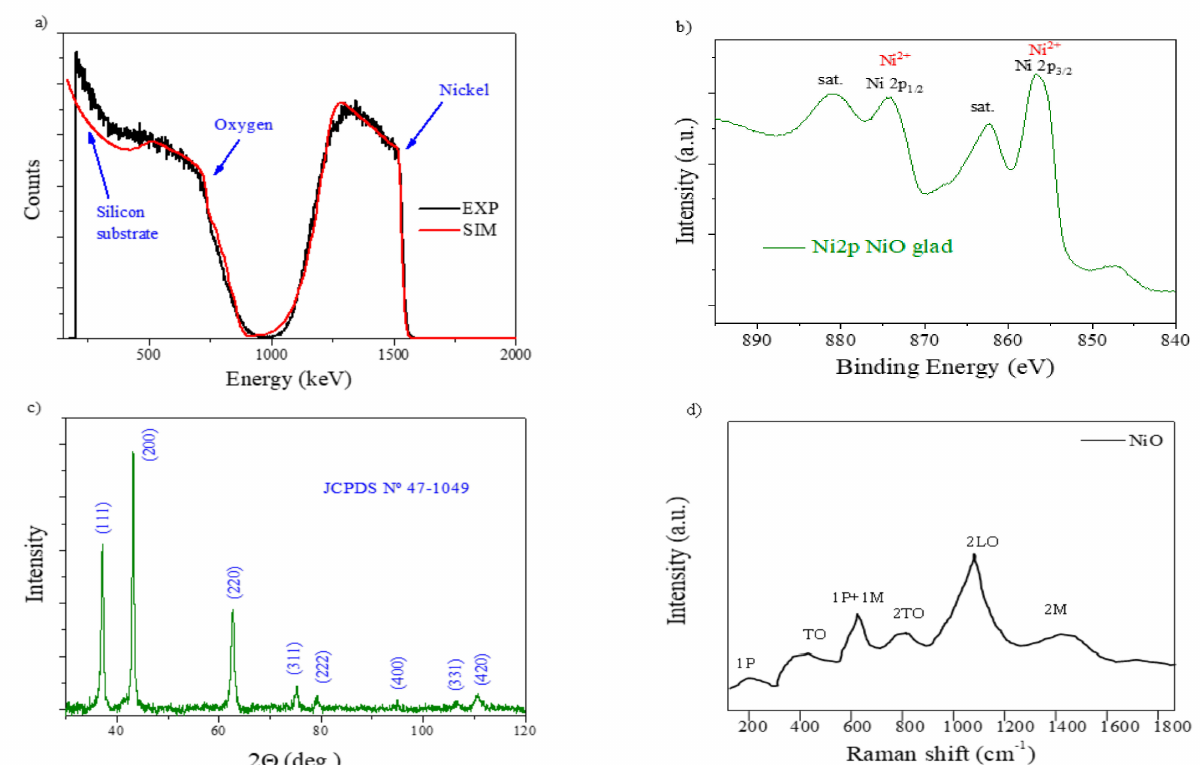
Figure 2. The physicochemical characterization of the as-prepared NiO thin film: ( a ) Rutherford backscattering (RBS); ( b ) X-ray photoelectron spectra; ( c ) X-ray diffraction (XRD); and ( d ) confocal micro-Raman. The density of the NiO MS-OAD thin film can be estimated using the mass thickness determined by RBS (i.e., the number of atoms per cm 2 ) and the thickness can be determined from the SEM cross-section image (Figure 1a). The calculated film density, 3.67 g cm − 3